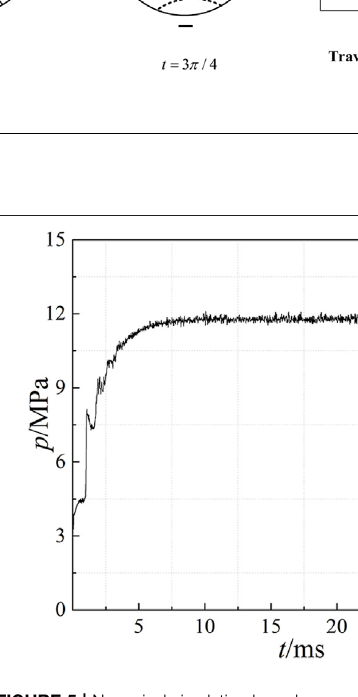
FIGURE 5 | Numerical simulation based on experiment (probe is near the wall and 50 mm downstream from injector